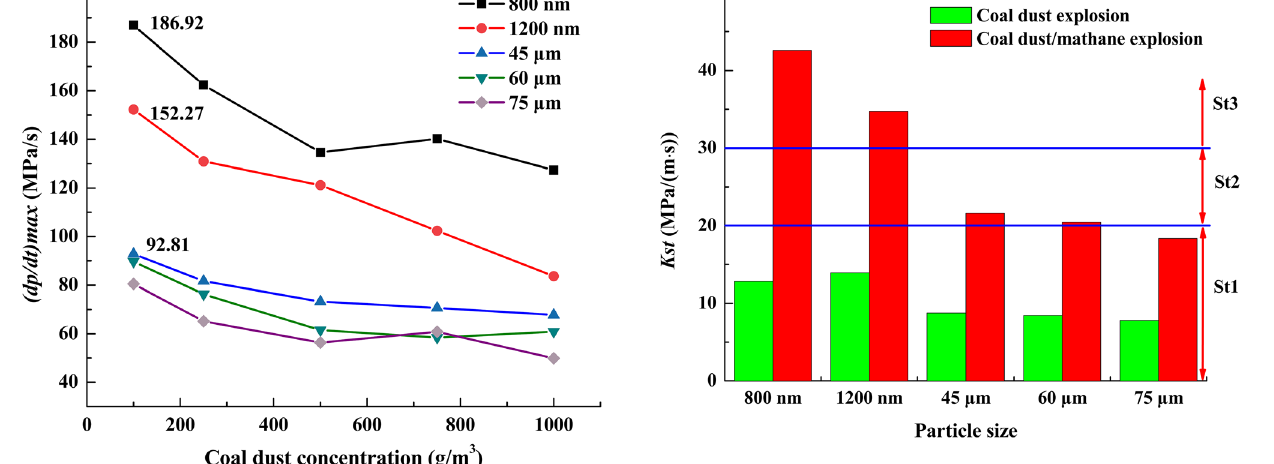
Fig. 12 Deflagration index comparison